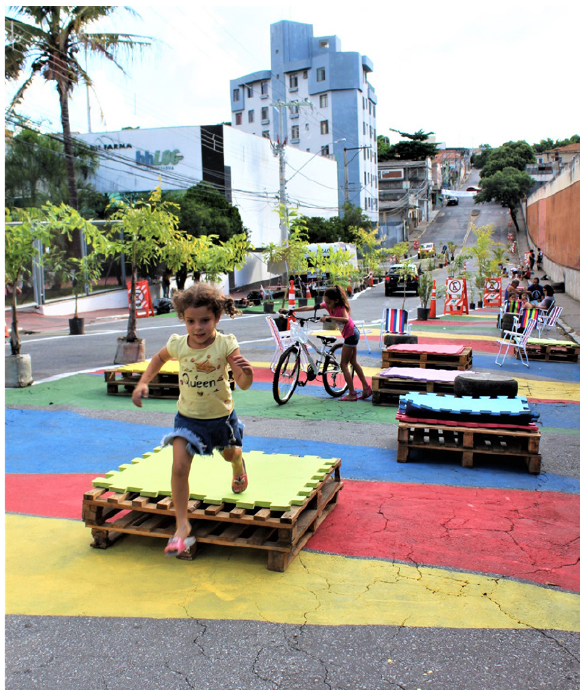
Figure 1. A tactical urbanism intervention in Brazil (Institute for Transportation and Development Policy,